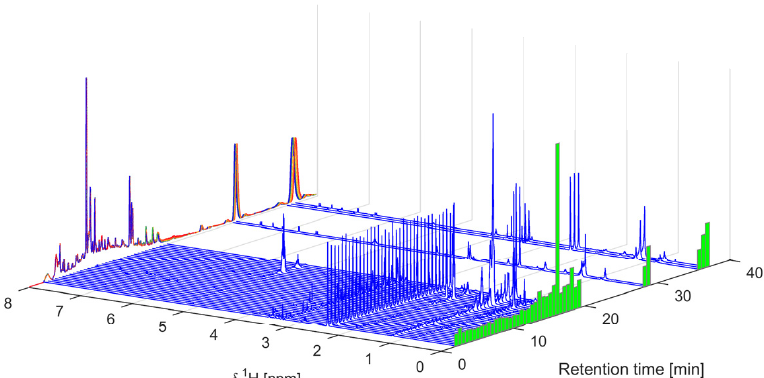
Figure 5. 1 H-NMR spectra of the 40 captured fractions dissolved in DMSO- d 6 and plotted on the retention time axis according to their collection. The corresponding UV-chromatograms (first separation in blue color, last in red, intermediate in green and yellow, 20 in total) are plotted along the left-hand side and the summed NMR intensities are plotted as green bars on the right-hand side. The NMR-data were normalized so that the residual DMSO-signal (at 2.50 ppm) is of equal area for all spectra.